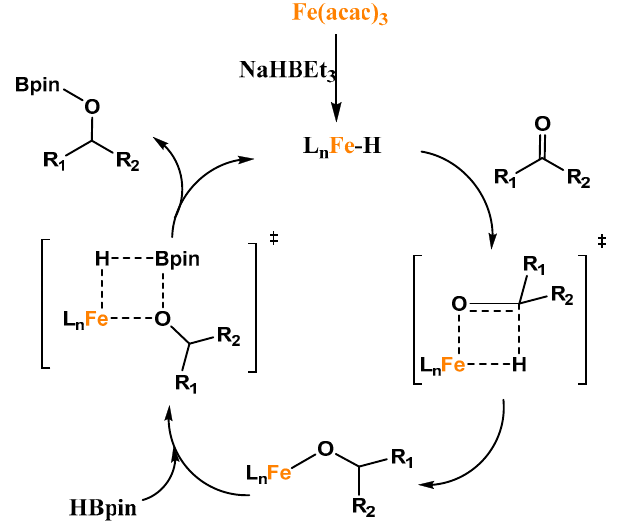
Figure 1. Proposed mechanism for hydroboration of carbonyls. 27.